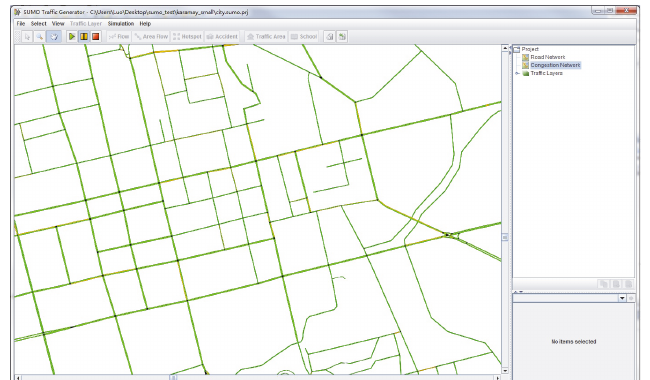
Figure 7: Detail of road network of Karamay.